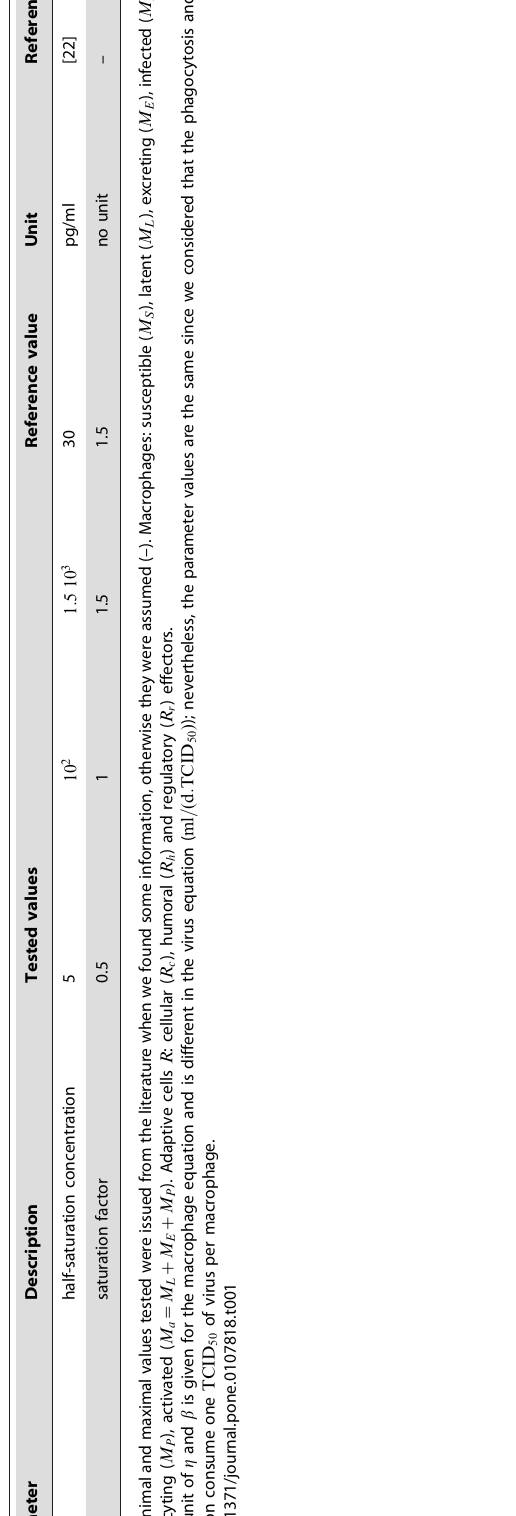
cytokine concentration. N Inhibition: R = ½ 1 z k ( C i ) (cid:2) . The flow decreases with the